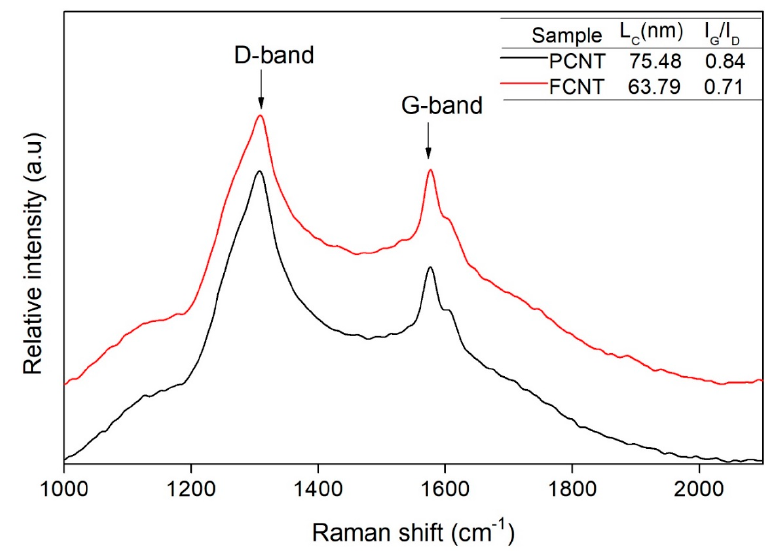
Figure 4. Raman spectra of pristine and vapor phase functionalized CNTs.